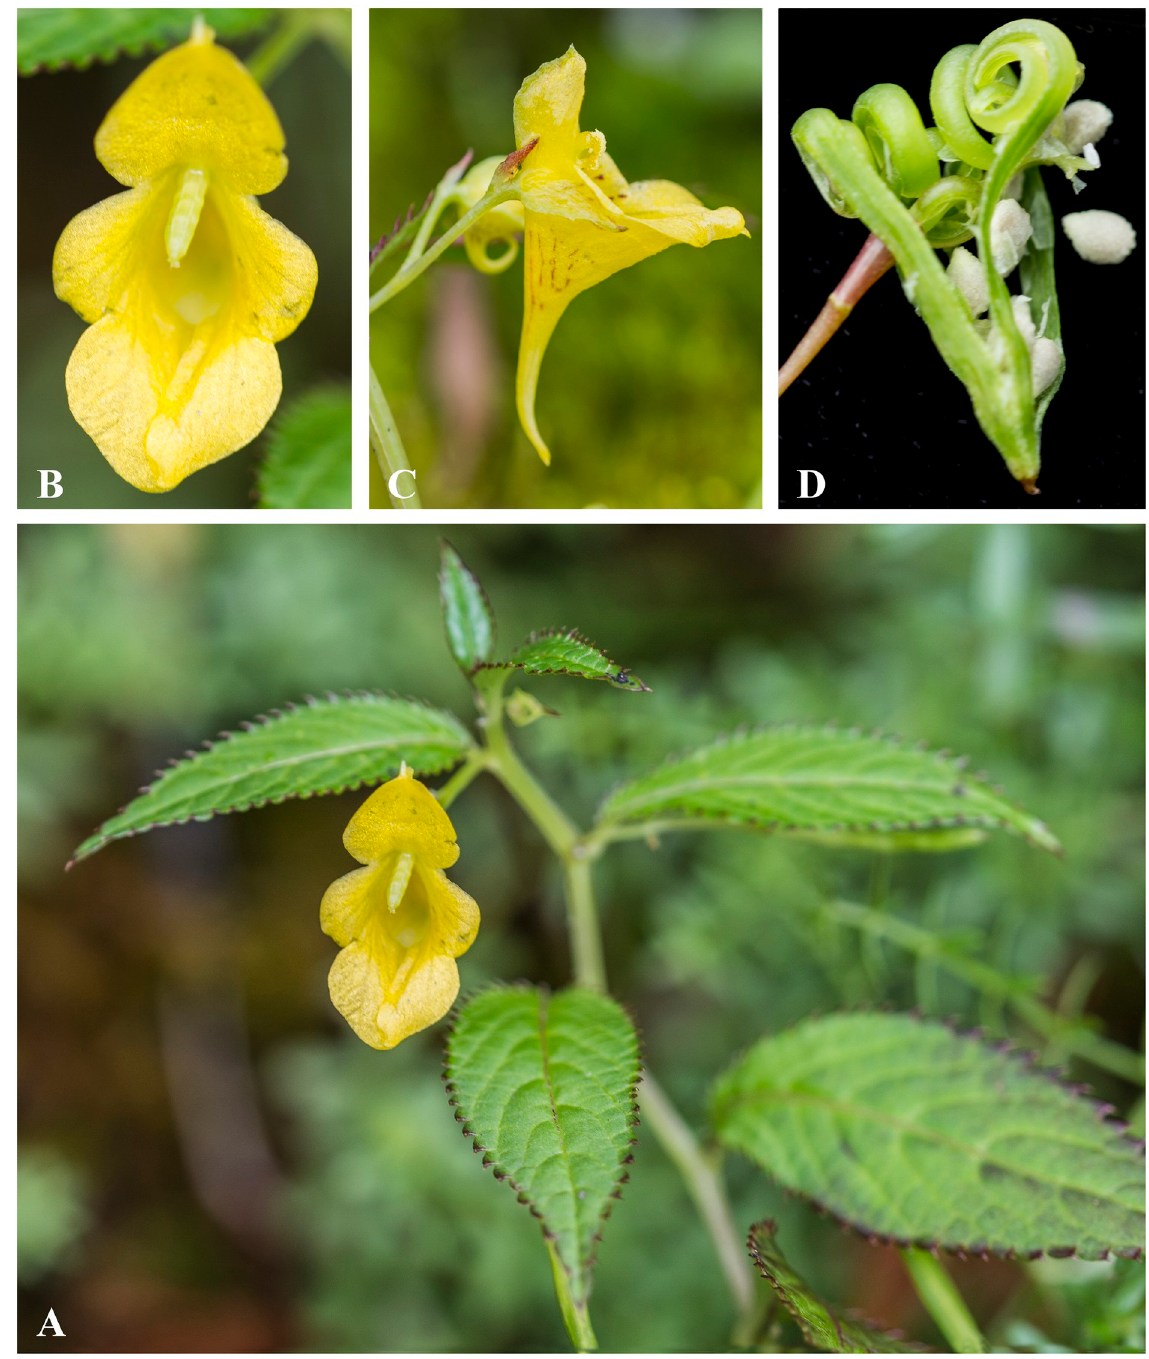
Fig 26. Impatiens serratifolia A. Flowering plant; B. Flower (Front view); C. Flower (side view); D. Capsule and seeds. Photographs by Bhakta Bahadur Raskoti.